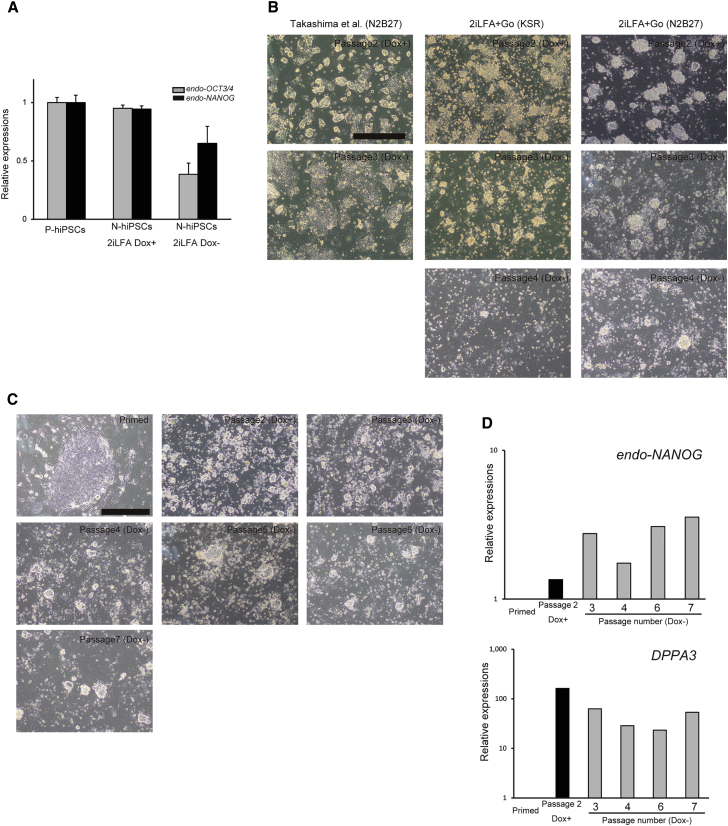
Culture Conditions for the Naive-like hiPSCs(A) qPCR analyses of pluripotency marker gene (OCT3/4 and NANOG) expressions in naive-like cells (201B7 N-hiPSCs) cultured in 2iLFA before and after the withdrawal of Dox, and in primed cells (201B7 P-hiPSCs) (n = 3, mean ± SEM; independent experiments).(B) Phase images of naive-like cells (201B7 N-hiPSCs) cultured in three different media before and after the withdrawal of Dox. 2iLFA + Go (KSR), KSR-based medium supplemented with 2iL, forskolin, TGF-β inhibitor, and PKC inhibitor; 2iLFA + Go (N2B27), N2B27-based medium supplemented with 2iL, forskolin, TGF-β inhibitor, and PKC inhibitor; Takashima et al. (N2B27), N2B27-based medium supplemented with 2iL and PKC inhibitor. Scale bar, 500 μm.(C) Phase images of 201B7 N-hiPSCs maintained in 2iLFA + Go (N2B27) through passages. Dox was withdrawn at passage 3. Scale bar, 500 μm.(D) qPCR analysis of DPPA3 and NANOG expressions in the 201B7 N-hiPSCs through the passages.